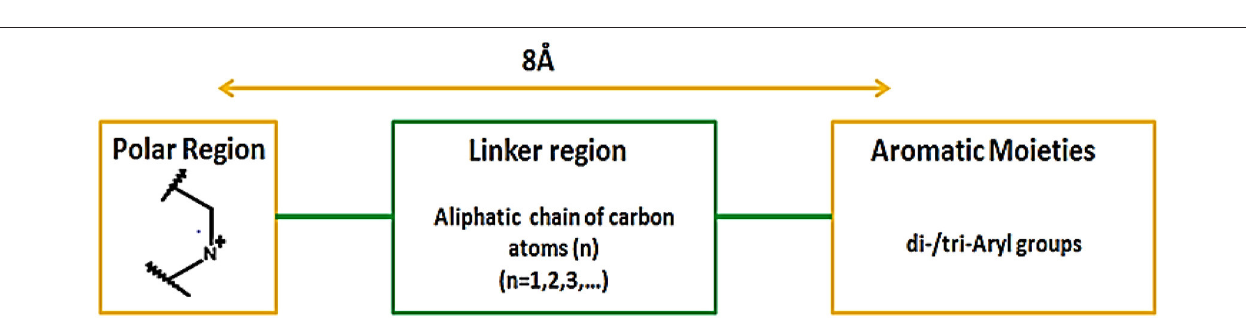
FIGURE 13 | Favorable distance between the aromatic moieties and protonated nitrogen atom of the polar region within the common scaffold of hGAT1 antagonist to achieve maximum inhibition of hGAT1, adopted from Hirayama et al.